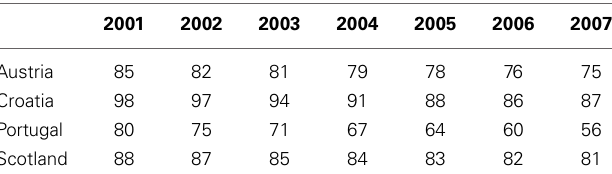
Table 2 | % Utilisation of all Angiotensin Converting Enzyme Inhibitors (ACEIs) vs. all renin-angiotensin inhibitor drugs among selected EU countries (DDD basis) from 2001 to 2007 (Vonˇcina et al.,